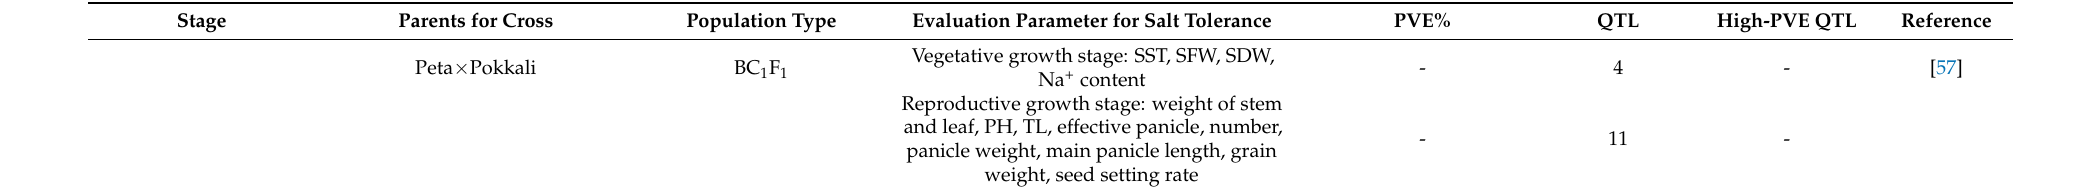
Stage Parents for Cross Population Type Evaluation Parameter for Salt Tolerance Reference Peta × Pokkali BC 1 F 1